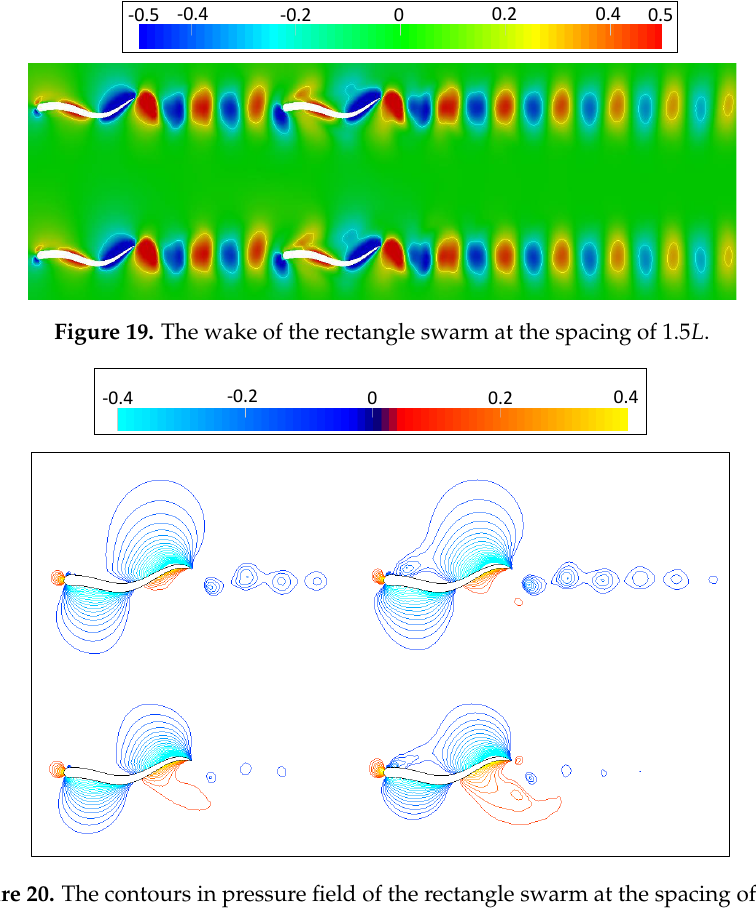
Figure 20. The contours in pressure field of the rectangle swarm at the spacing of 1.5 L